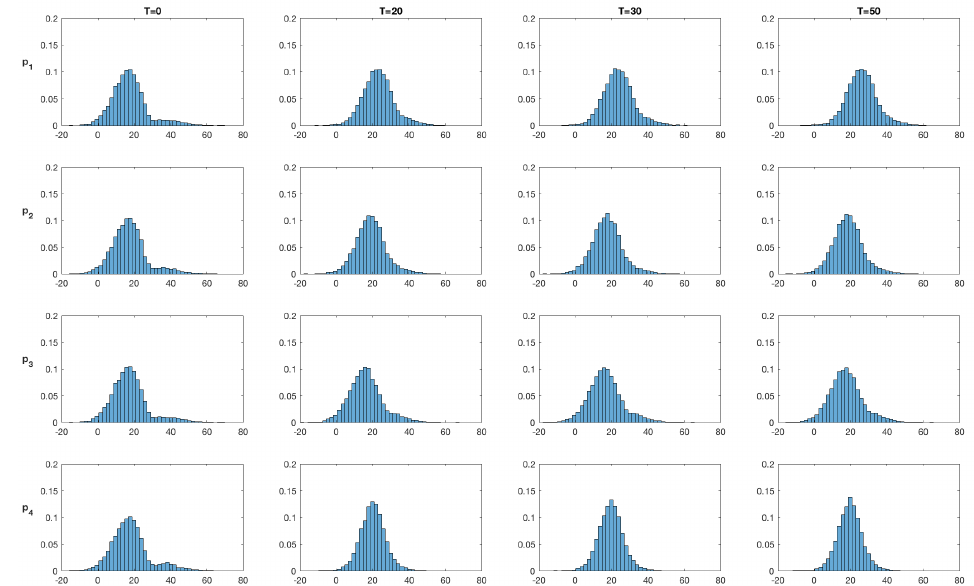
Figure 17. EnKS approach: Marginal posterior distributions of the initial temperature f ( r 0, i | d 0: T ) at time T = 0,20,30,50 at monitoring locations ( i = 1,2,3,4) denoted ( p 1 , p 2 , p 3 , p 4 ). The horizontal axes representing temperature are expressed in ◦ C.